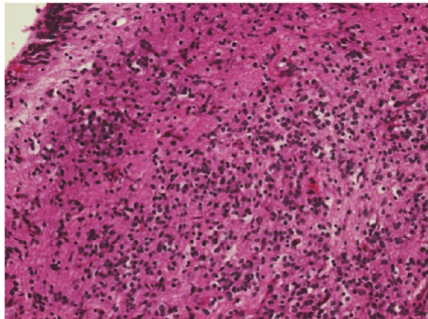
Figure 4: Histological section showing immature teratoma com- posed of small immature neurogenic cells (hematoxylin and eosin, 100x magnification).